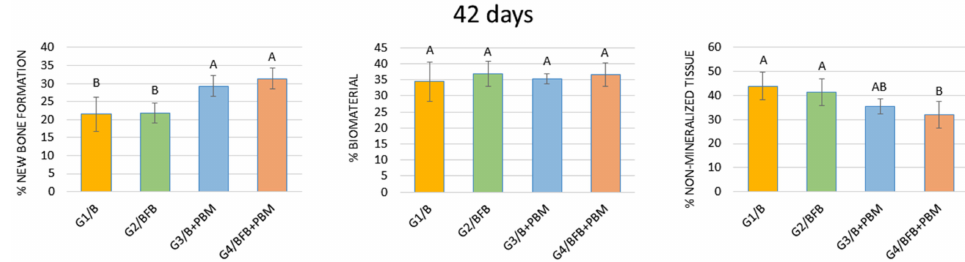
Figure 11. Percentage of new bone formation, biomaterial, and non-mineralized tissue in the experi- mental groups at 42 days. The different letters (A (cid:54) = B) indicate a statistically significant difference ( p <